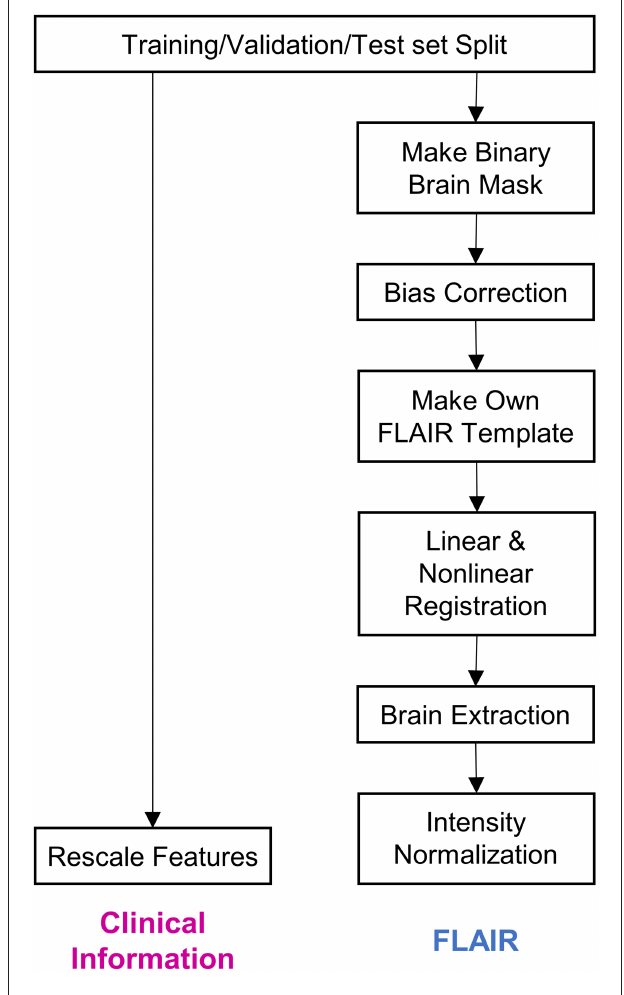
FIGURE 1 | Steps of data preprocessing. The diagram depicts the preprocessing of data before it was input into the deep learning model. Firstly, the whole dataset was split into training, validation, and test sets. Subsequently, clinical information and fluid-attenuated inversion recovery (FLAIR) images were preprocessed separately. The details regarding the preprocessing procedure have been described in the Methods section.